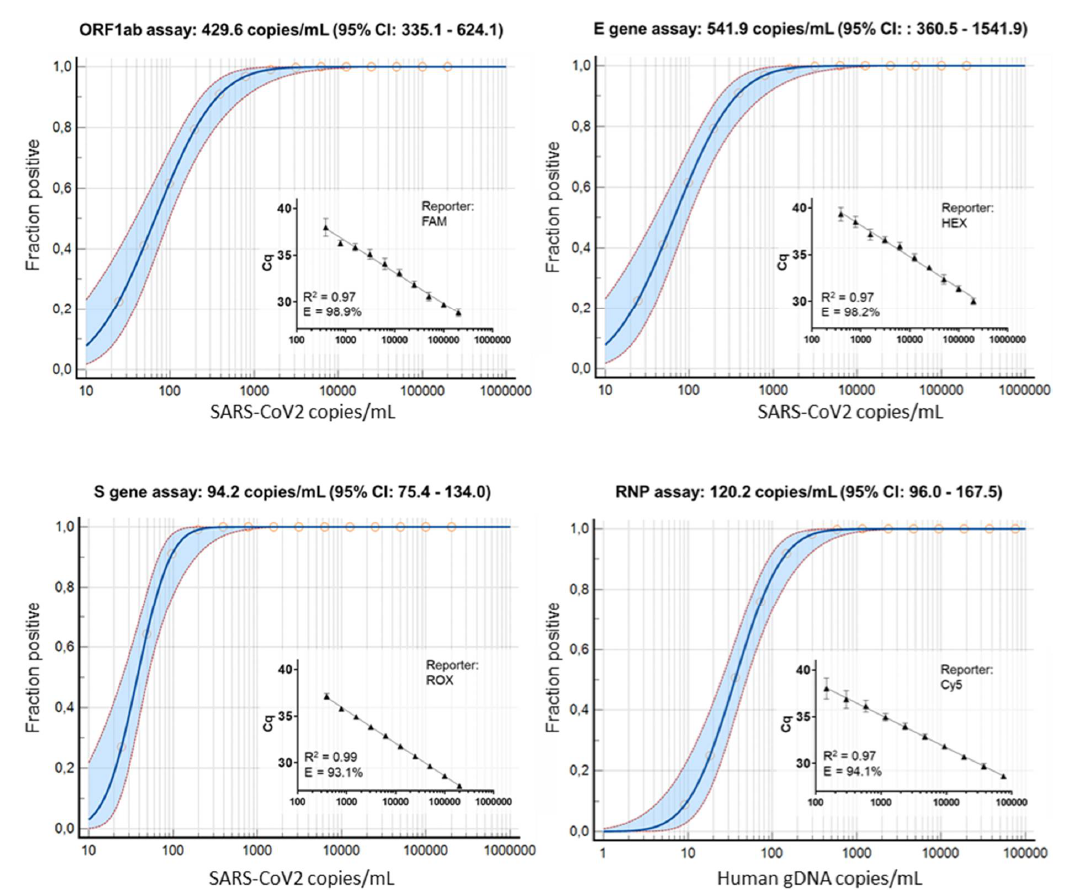
Figure 2. Determination of limits of detection based on the standard reference EDX SARS-CoV-2 for the three SARS CoV-2 genes (ORF1ab, S and E) and the human RNP gene. The x -axis shows nucleic acid copies per milliliter. The y -axis shows positive results in all reactions performed. Red circles represent fourteen experimental data points, each resulting from fifteen replicate testing. The fourteen data points were generated by serial 1:2 dilution of the standard reference EDX SARS-CoV-2 ranging from 200,000 copies/mL up to 24.4 copies/mL of SARS-CoV-2 synthetic RNA and 75,000 copies up to 9.2 copies/mL from human genomic DNA. Technical limits of detection are given in the panel headings. The blue inner line is a probit curve (dose–response analysis). The outer red lines are 95% probability confidence interval (CI). Inner graphs are standard curves generated from the mean quantification cycle (Cq) values (± SD for three independent assays each with three technical replicates) obtained against the copy number quantification of standard reference EDX SARS-CoV-2. The qPCR efficiency, coefficient of determination (R 2 ) and the fluorophore tagged at the 5′ end of the probe (reporter) are also displayed in the inner graphs. RNP primers and probe nucleotide sequences previously designed [12] . ORF, open reading frame; E, envelope; S, spike; RNP, ribonuclease P; SARS-CoV-2, Severe Acute Respiratory Syndrome Coronavirus 2.